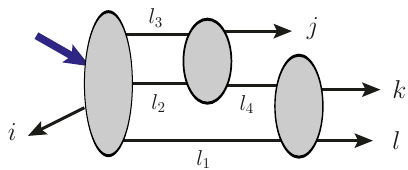
Figure 13. Unitarity cuts that can determine the remaining degrees of